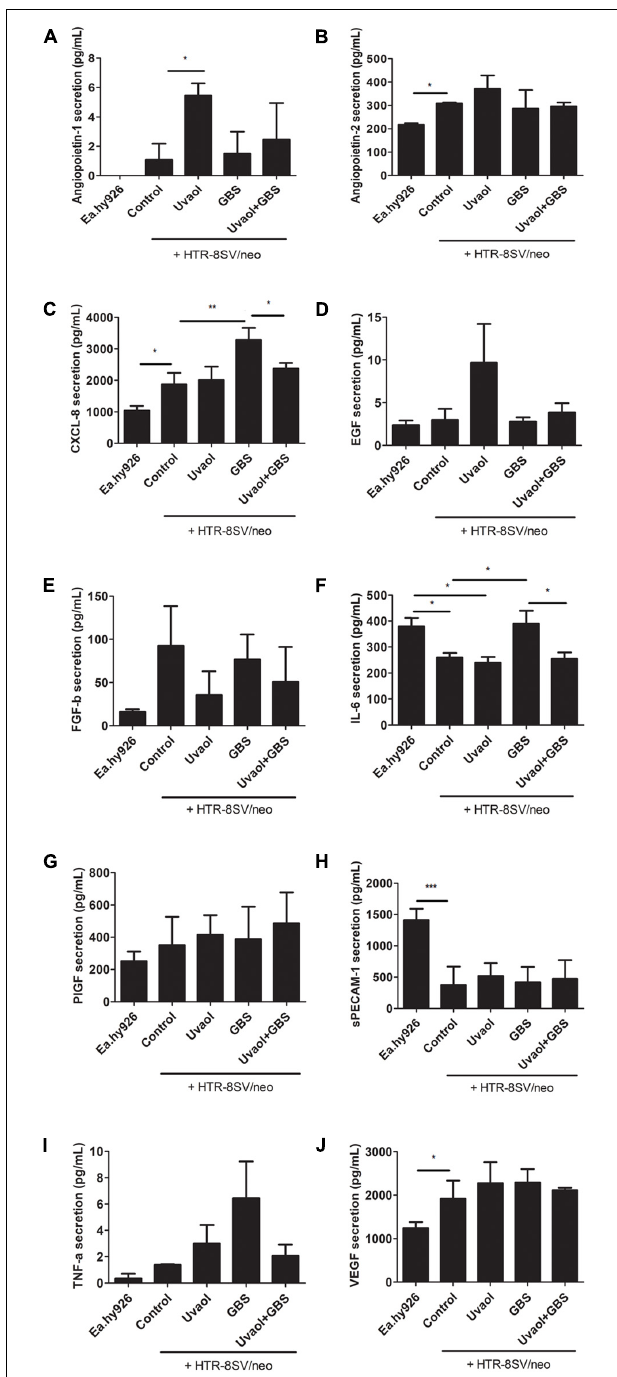
FIGURE 6 | Vasoactive factors secretion from the 3D coculture vascular invasion assay. The bottom supernatants from the 3D coculture vascular invasion assay were collected and analyzed for angiopoietin-1 (A) , angiopoietin-2 (B) , CXCL-8 (C) , EGF (D) , FGF-b (E) , IL-6 (F) , PlGF (G) , sPECAM-1 (H) , TNF- α (I) , and VEGF (J) through flow cytometry. The analyzed groups were composed by Ea.hy926 endothelial cells alone, with HTR8SV/neo trophoblast cells (control), added with 10- µ M uvaol or GBS at 1 × 10 6 CFU, or both (uvaol + GBS). A bar graphs represent mean values ± S.E.M.; n = 3 in triplicate. *, p < 0.05; **, p < 0.01; ***, p <